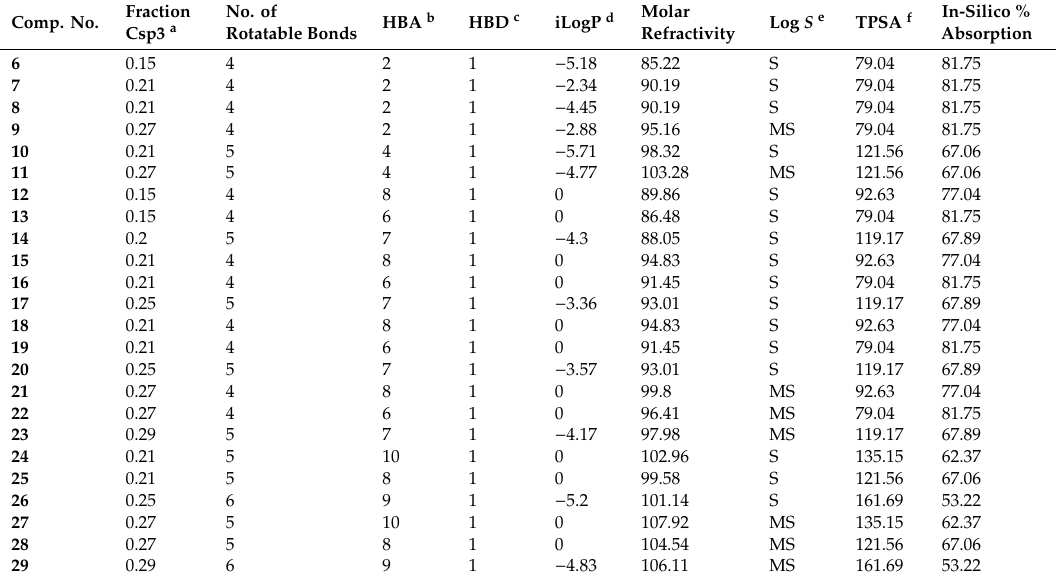
a The ratio of sp 3 hybridized carbons over the total carbon count of the molecule; b number of hydrogen bond acceptors; c number of hydrogen bond donors; d lipophilicity; e water solubility (SILICOS-IT[ S = Soluble, MS = Moderately Soluble]); f topological polar surface area (Å 2